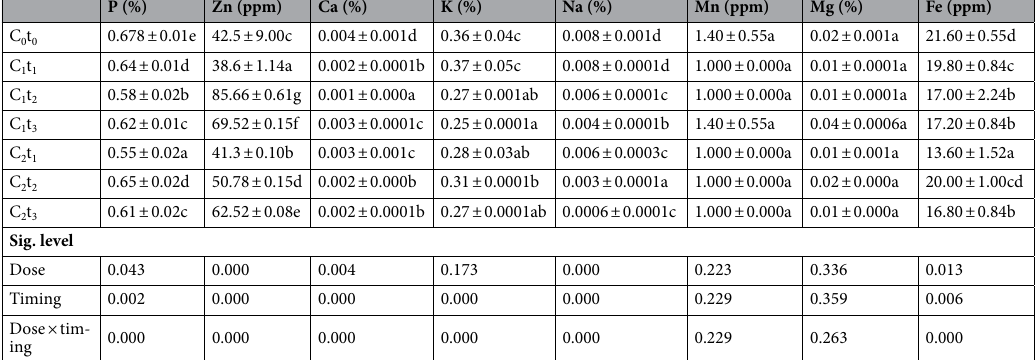
Table 7. Mineral composition of P. ostreatus mushrooms cultivated on supplemented substrates. C 1 3 g kg −1 , C 2 5 g kg −1 , t 1 supplementation at spawning, t 2 supplementation after the first harvest, t 3 supplementation at spawning and after the first harvest. Values are means; means within the same column followed by the same letters are not significantly different at P < 0.05 according to Duncan’s multiple range